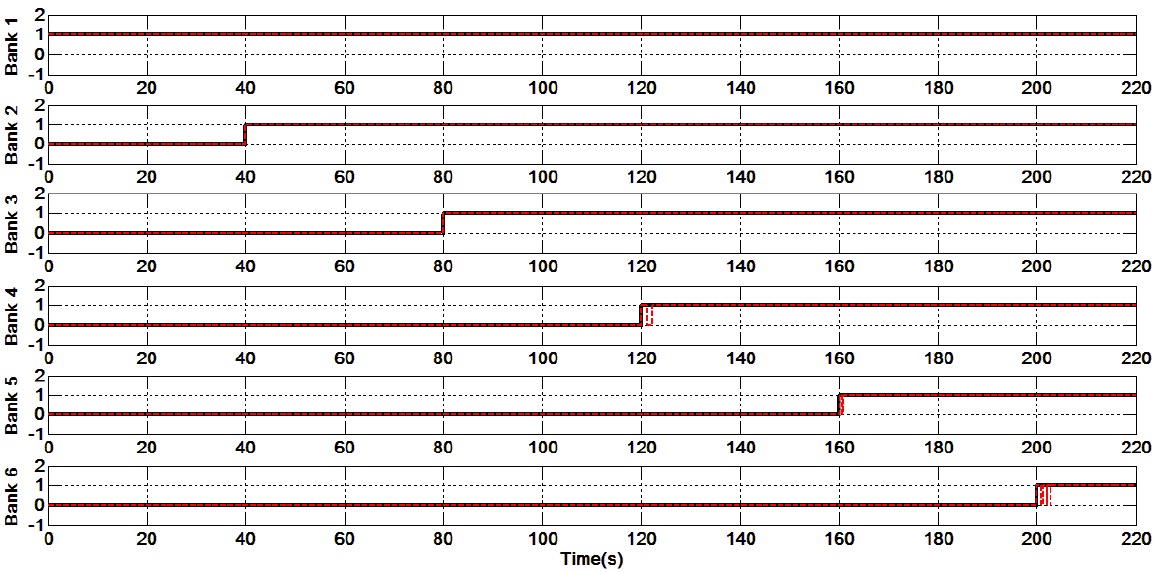
Figure 12. Generated power and pitch angle under PI fluctuation